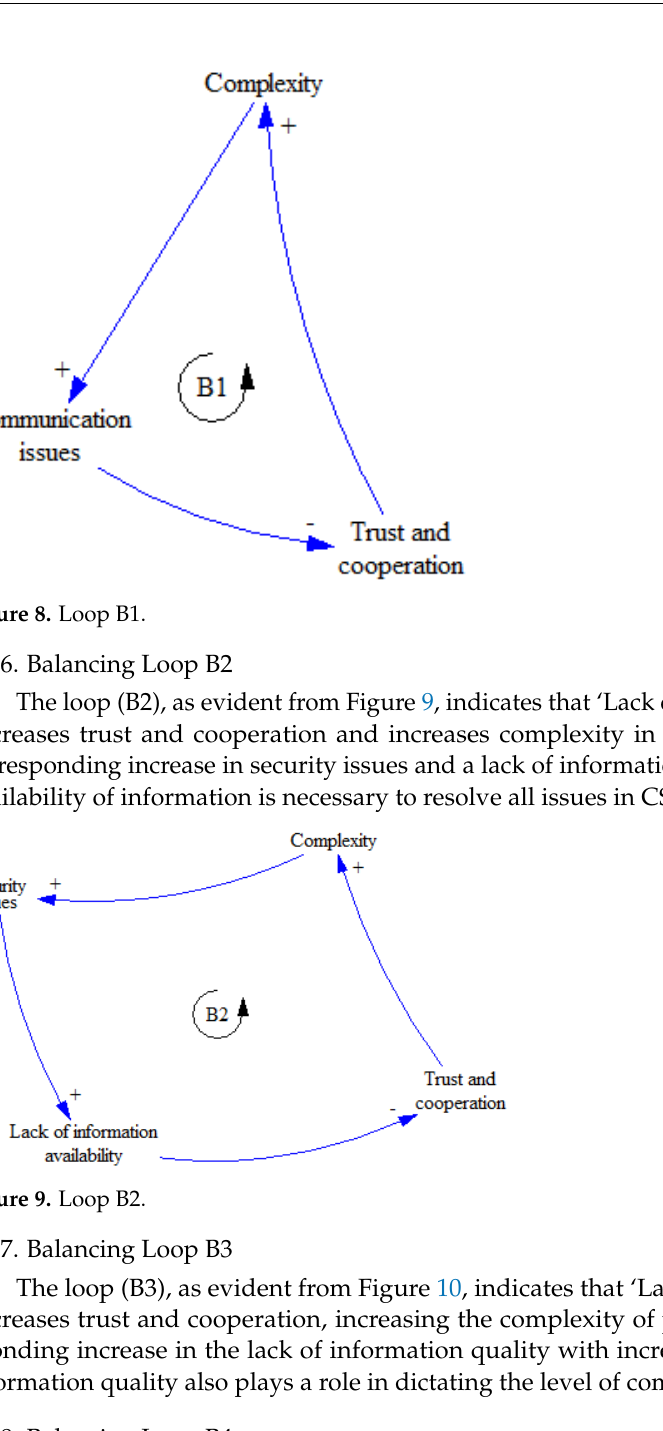
15 of 24 Figure 7. Loop R4. 4.1.5. Balancing Loop B1 The loop (B1), as evident from Figure 8, indicates that ‘Communication issues’ lead to a corresponding decrease in trust and cooperation throughout CSCs. Further, a